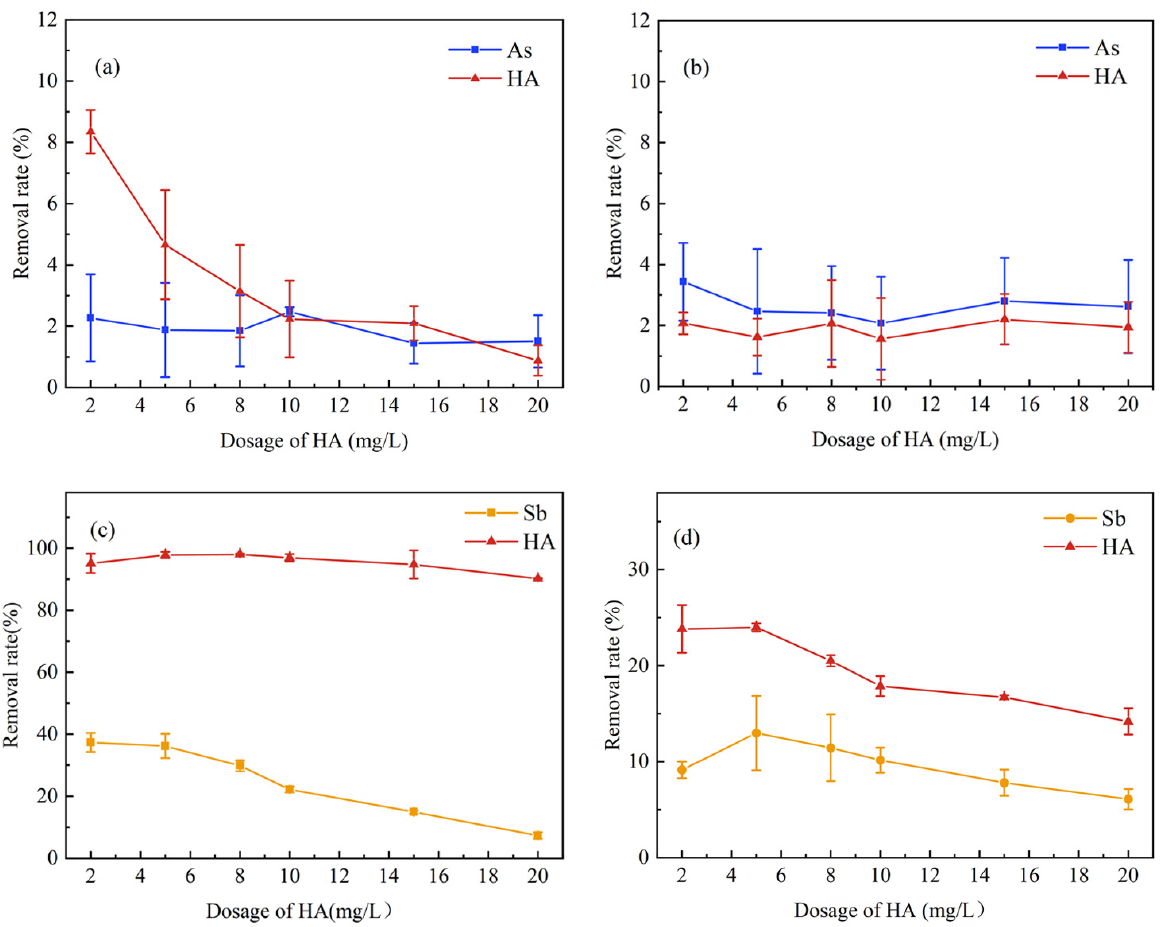
Figure 2. Effect of HA concentration on the removal of As and Sb (( a ) K 2 FeO 4 (Fe of 2.26 mg/L) +HA + As, pH = 6.5; ( b ) HA + As, pH = 6.5; ( c ) K 2 FeO 4 (Fe of 3.39 mg/L) + HA + Sb, pH = 4.5; ( d ) HA + Sb, pH = 4.5).